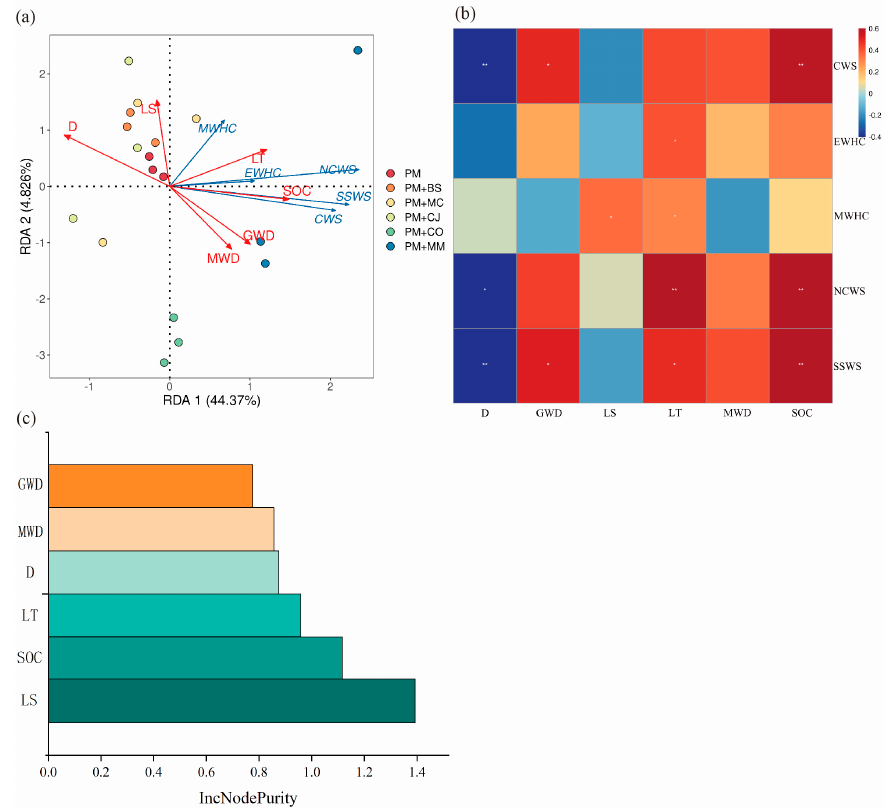
Figure 4. Factors influencing the water conservation capacity of the litter-soil continuum. ( a ) Redun- dancy analysis (RDA) for the associations of environmental factors with water conservation capacity. ( b ) Correlation between environmental factors and water conservation capacity. ( c ) Independent effects of environmental factors on water conservation capacity. Note: SOC: soil organic carbon; LS: litter stock; LT: litter thickness; GMD : geometric mean diameter; MWD : mean weight diameter; SSWS : soil saturated water storage; D : fractal dimension; CWS : capillary water storage; MWHC : water-holding capacity of litter. Pinus massoniana (PM), Bretschneidera sinensis ( BS ) , Manglietia chingii